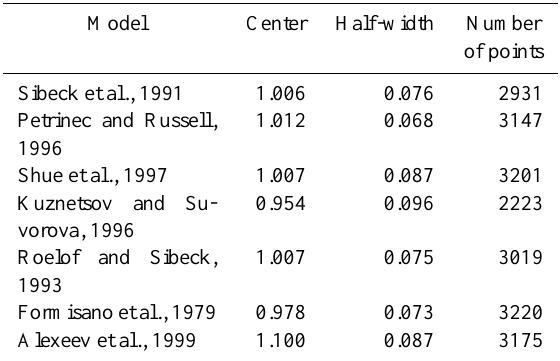
Table 2. Comparison of models in GSE coordinates